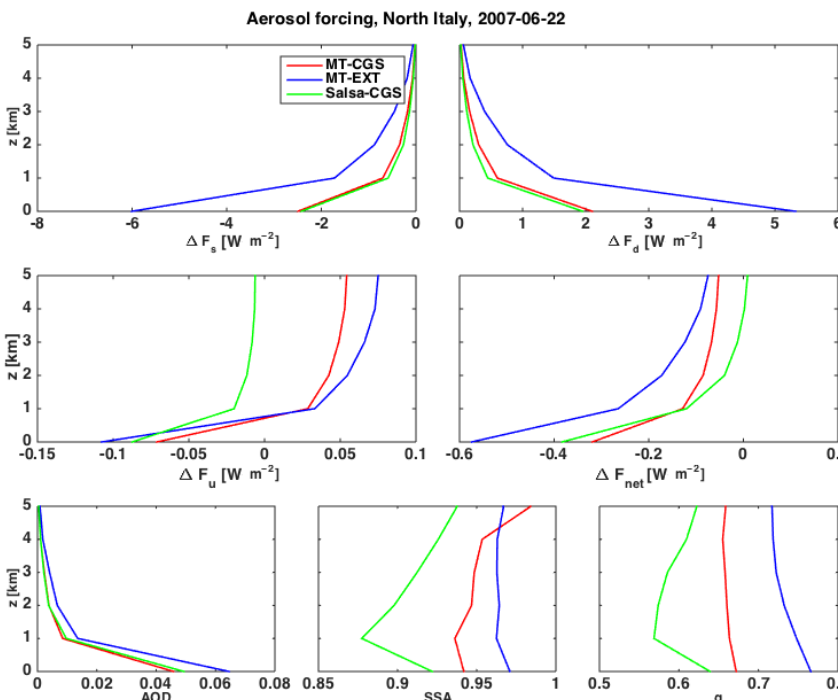
Figure 5. Aerosol forcing and optical properties at 532(CGS)/500(EXT)nm over northern Italy in June. Results are shown for the three model versions MT-EXT (blue), MT-CGS (red), and SALSA-CGS (green). The aerosol forcing is derived by taking the difference in radiative fluxes between an aerosol-laden and clear sky. The difference in direct ( (cid:49)F s ) and diffuse ( (cid:49)F d ) downwelling, as well as the diffuse upwelling ( (cid:49)F u ) and the net radiative flux (aerosol forcing) ( (cid:49)F net = (cid:49)F s + (cid:49)F d − (cid:49)F u ), are shown in the first four figures (first and second row of plots). The optical properties aerosol optical depth (AOD), single scattering albedo (SSA), and asymmetry parameter ( g ) are shown in the third row of